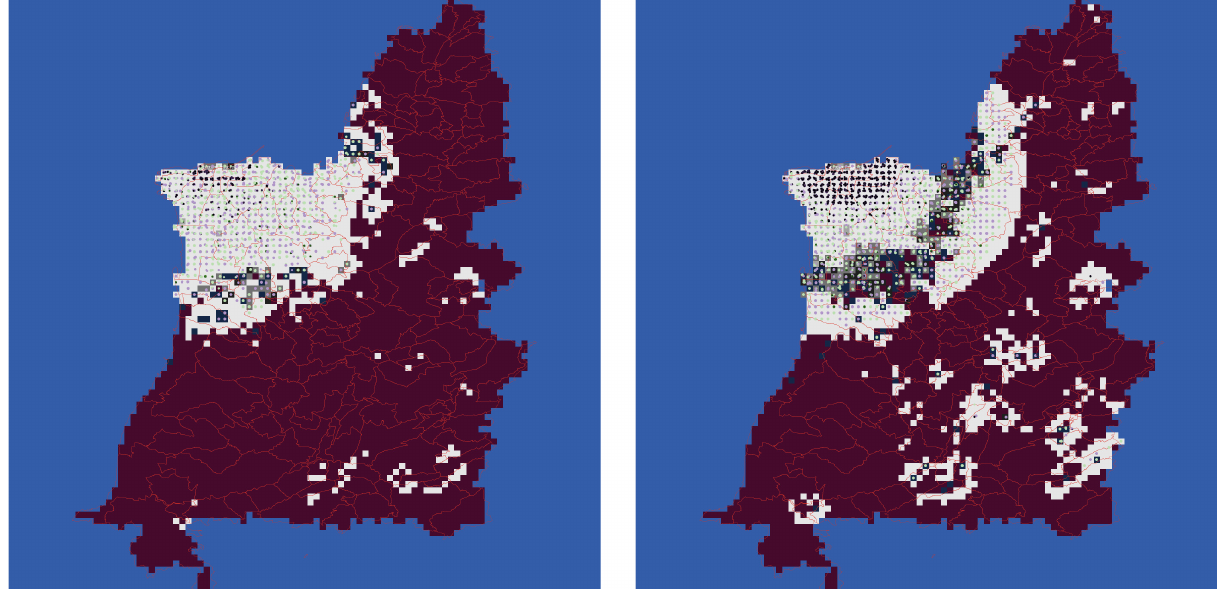
Figure 6. Eight years after the explosion (left); same time point in no‐explosion scenario